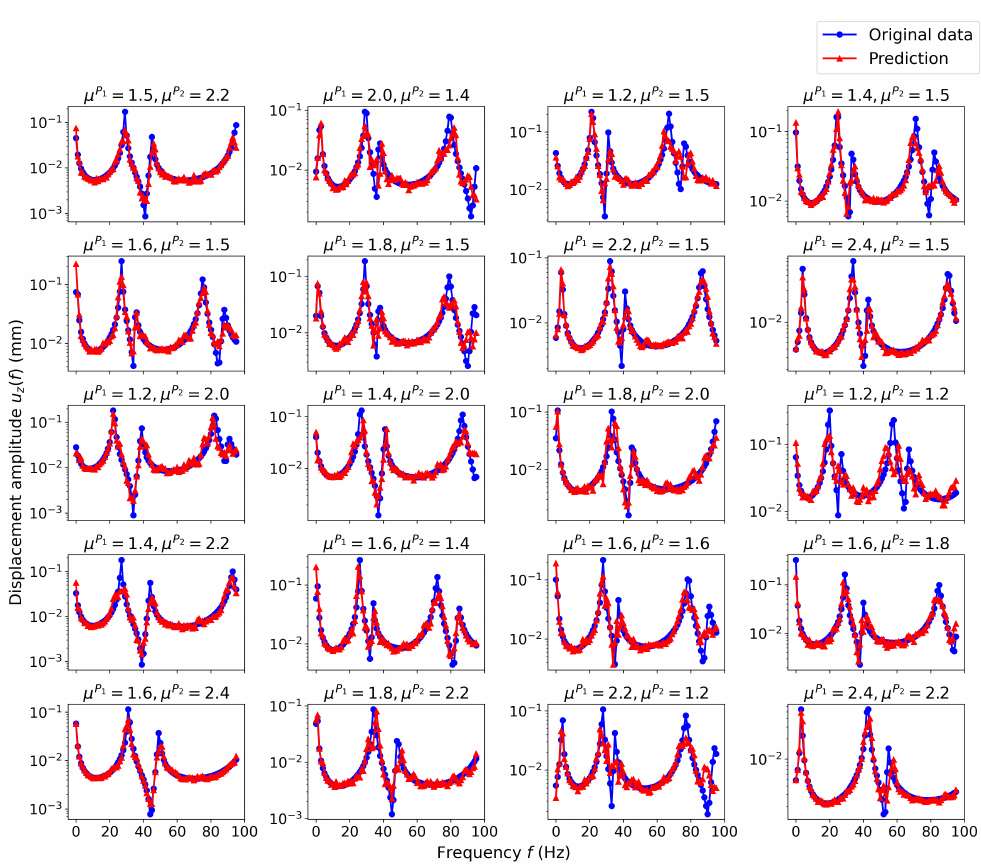
Figure 13. Results of surrogate model H 3 for 20 samples in the testing set. Thickness values in subfigure titles are expressed in